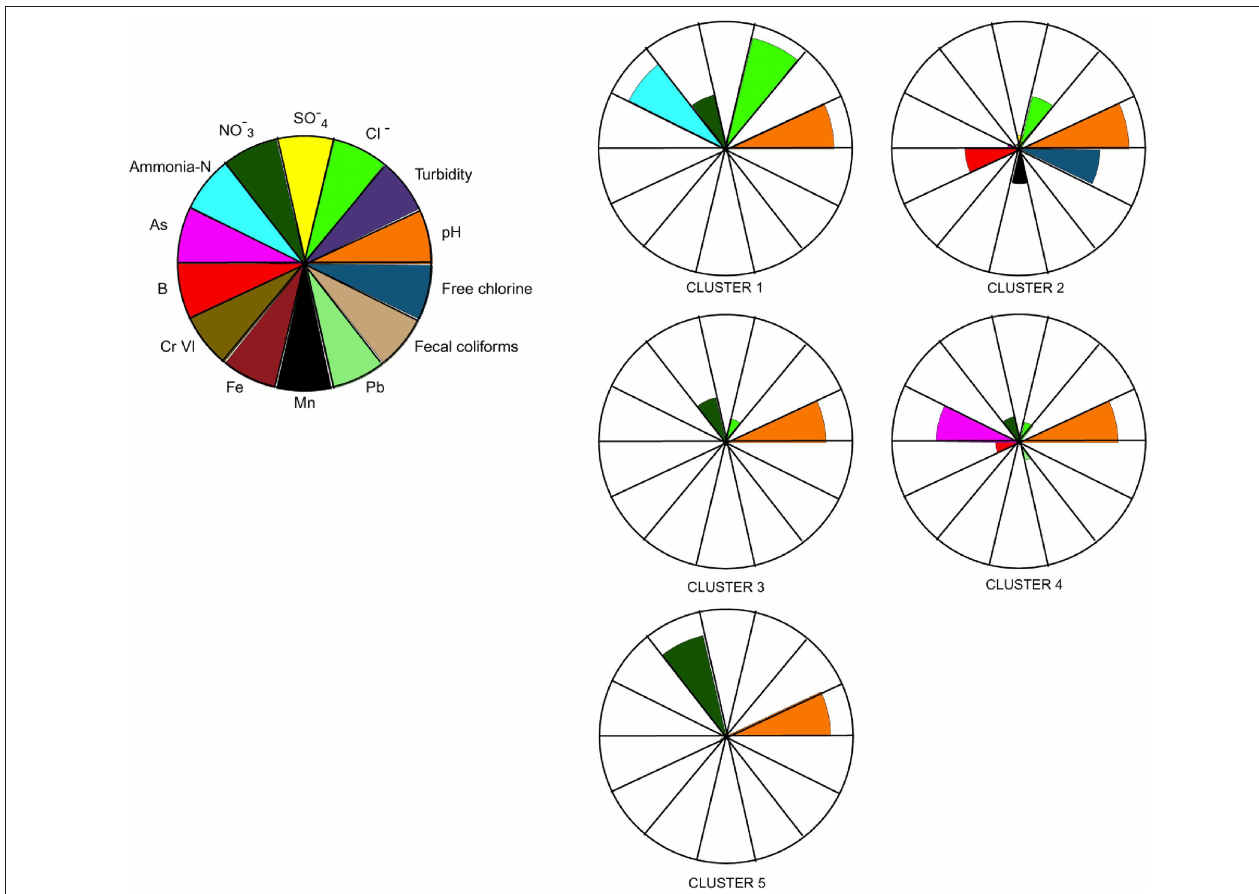
FIGURE 2 | Cluster models generated with groundwater quality information, figure shows number of data included to generate clusters. Number of data by cluster 231, 149, 347, 561, and 254 for cluster 1, 2, 3, 4, and 5,